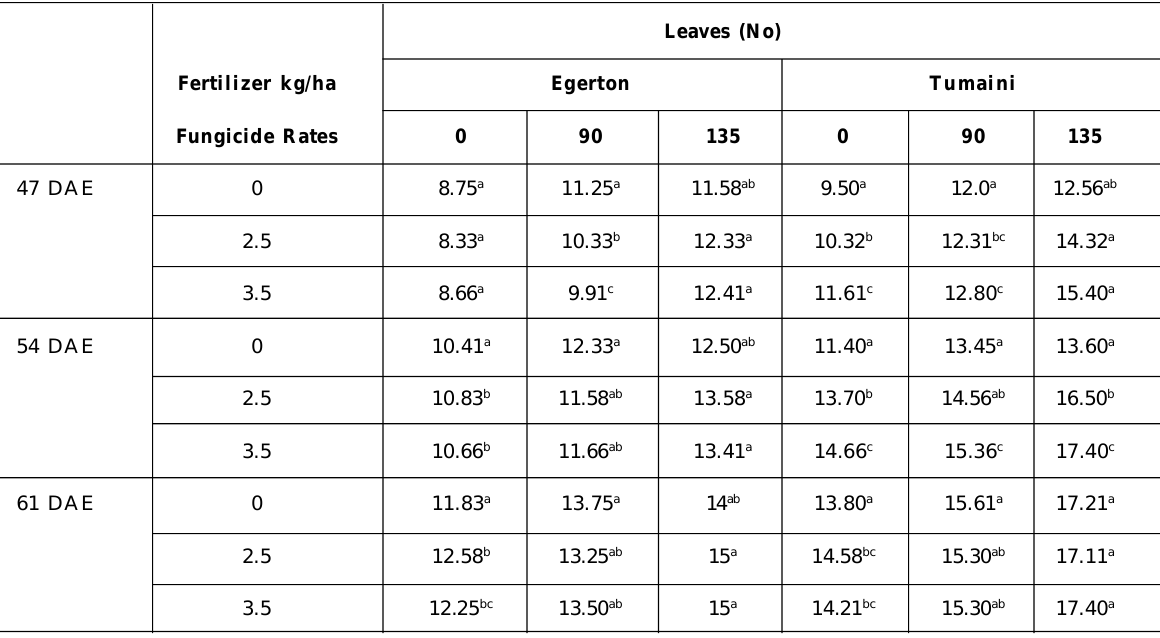
Table 5: The effects of fertilizer and fungicides interaction on the number of leaves on potato crop Leaves (No) Fertilizer kg/ha Egerton Tumaini Fungicide Rates